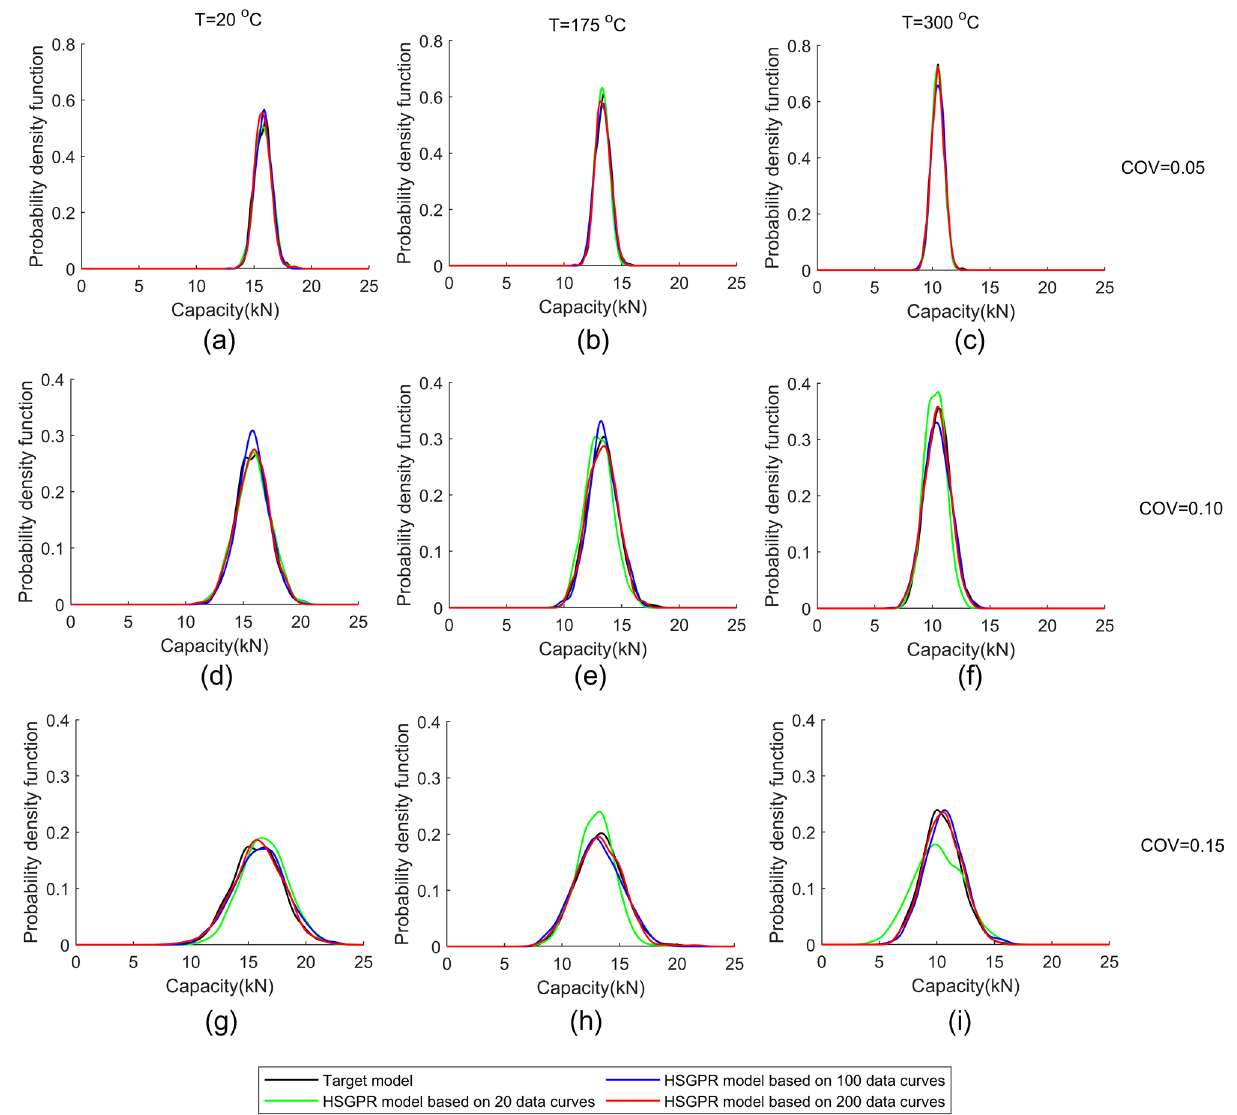
Figure 13. The probability density distribution of the structural capacity given by the HSGPR-based flow stress model and the target model at different dataset size, temperatures and coefficient of variation (COV). ( a ) COV = 0.05, T = 20 °C, ( b ) COV = 0.05, T = 175 °C, ( c ) COV = 0.05, T = 300 °C, ( d ) COV = 0.10, T = 20 °C, ( e ) COV = 0.10, T = 175 °C, ( f ) COV = 0.10, T = 300 °C, ( g ) COV = 0.15, T = 20 °C, ( h ) COV = 0.15, T = 175 °C, ( i ) COV = 0.15, T = 300